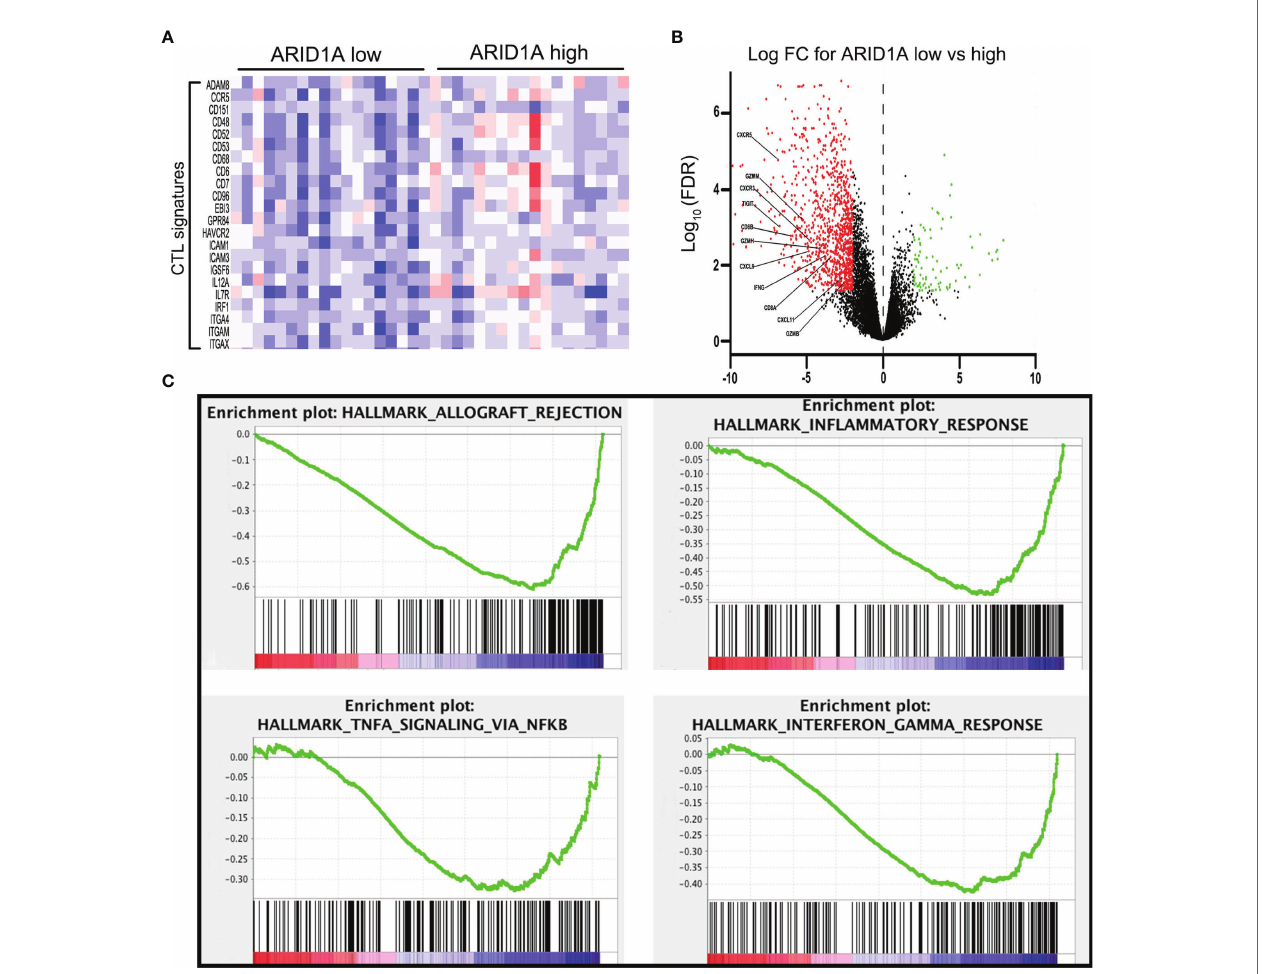
FIGURE 2 | Bioinformatics analysis revealed the regulation of immune-related genes and signaling pathways in AT-rich interactive domain 1A (ARID1A)-inactivated tumors. (A) Heatmap of cytotoxic T lymphocyte (CTL) signatures in tumors with high or low ARID1A expression. (B) Volcano plot presenting the downregulation of genes involved in CD8+ T-cell activation in ARID1A-inactivated tumors. (C) Gene set enrichment analysis revealed the downregulation of the immune-related pathway in ARID1A-inactivated